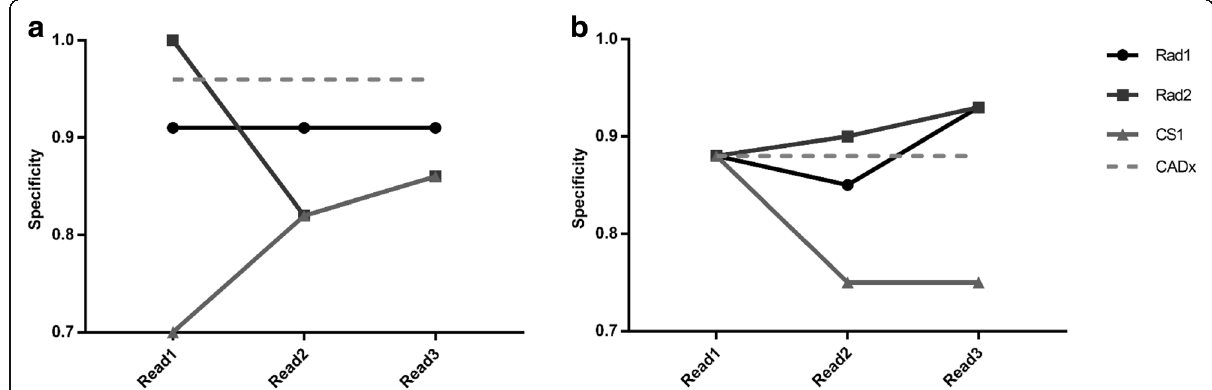
Fig. 5 Specificity figures for the three image reads. Specificity figures for the three image reads, for local data ( a ) and PPMI data ( b ). Standalone CADx performance is also shown, for